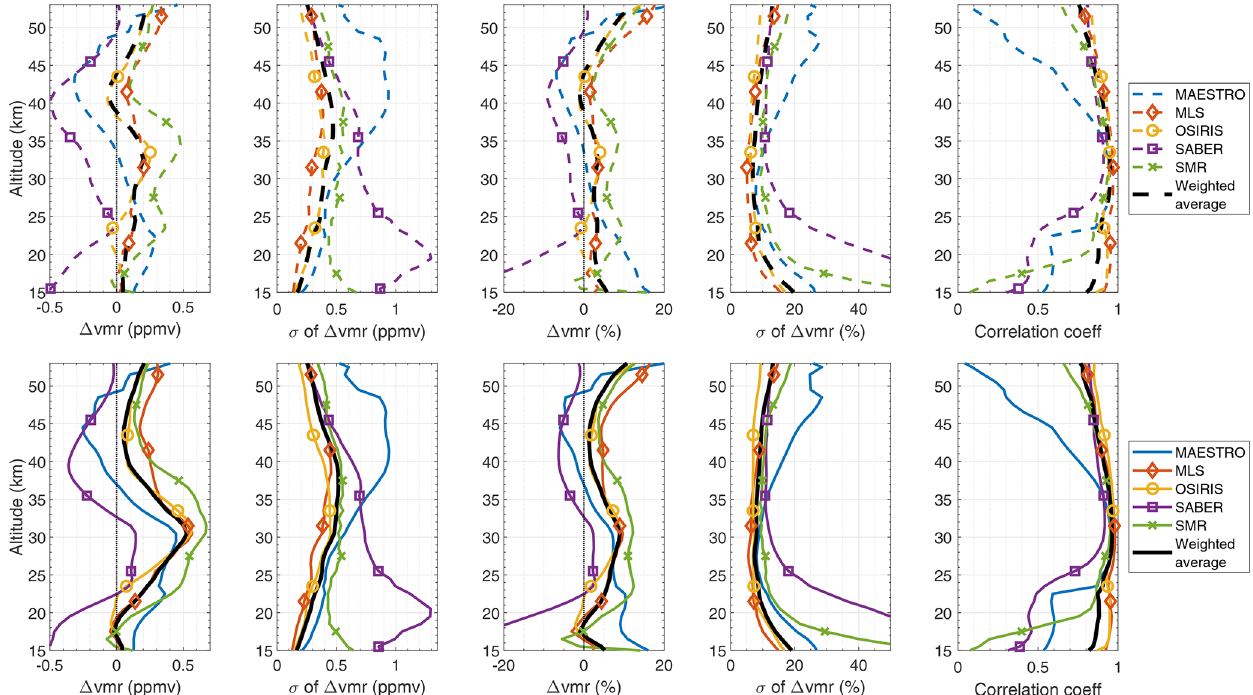
Figure 1. Comparisons between ACE-FTS O 3 and MAESTRO (blue), MLS (red), OSIRIS (yellow), SABER (purple), and SMR (green) with coincidence criteria of within 6h and 300km for all coincident profiles within 2004–2020. ACE-FTS v3.6 (top) and v4.1 (bottom). From left to right the plots show the mean of the differences between ACE-FTS and INST in ppmv, the standard deviation of the differences between ACE-FTS and INST in ppmv, the mean of the relative differences between ACE-FTS and INST in percent, the standard deviation of the relative differences between ACE-FTS and INST in percent, and the correlation coefficients. The black line in each plot provides the weighted average (see text).